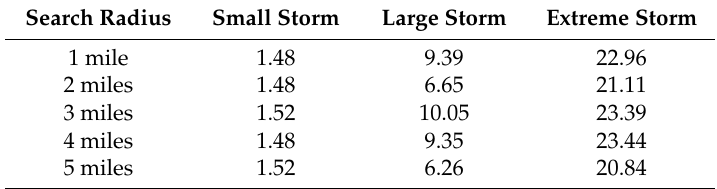
Figure 9. Change of radius for nearest-with-radius search strategy. Crew start location set to area work center and search strategy set to most customers affected within a radius of the nearest outage. Search radius varied as indicated. Travel speed set to 25 mph, 272 crews with 85% working during day shift, 99% working during evening shift and 66% working during night shift, 1 to 10 h repair time range. 1000 outages for small storm, 5000 outages for large storm, 15,000 outages for extreme storm. Table 6. Time to system restoration (in days) based on search radius from Figure